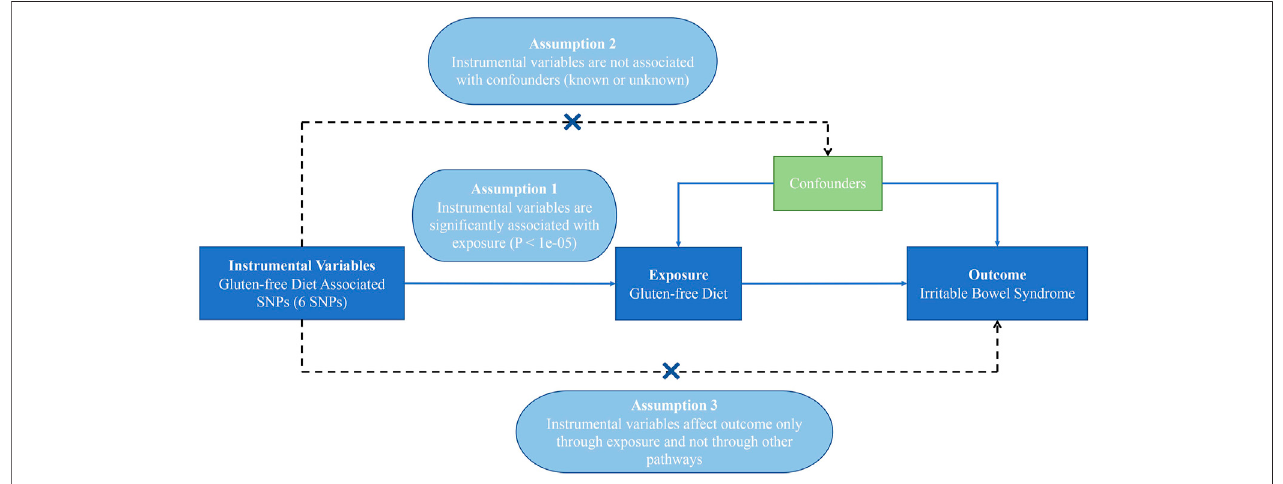
FIGURE 1 | Diagram of the Mendelian randomization assumptions supporting a two-sample Mendelian randomization analysis of the causal effect of gluten-free diet on irritable bowel syndrome (the dashed lines indicate possible causal effects between variables which may be against the Mendelian randomization assumptions).